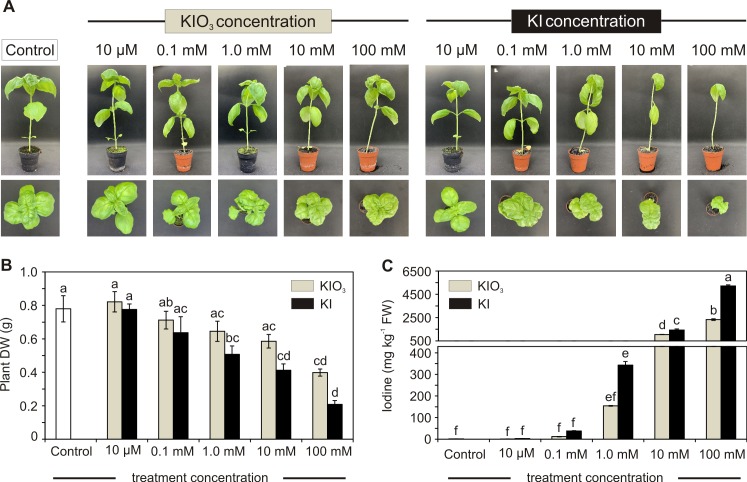
Effect of iodine on plant growth in growth chamber experiment.Basil phenotype of control and KI or KIO3 (0; 10 μM; 0.1 mM; 1 mM; 10 mM; 100 mM) treated plants at harvest (A); effects of increasing iodate and iodide concentrations on basil dry weight (DW) (B) and on leaf iodine content (C). Error bars are presented on graphs. One-way ANOVA was performed. Different letters indicate significant differences between treatments (Tukey’s test, P≤0.05).